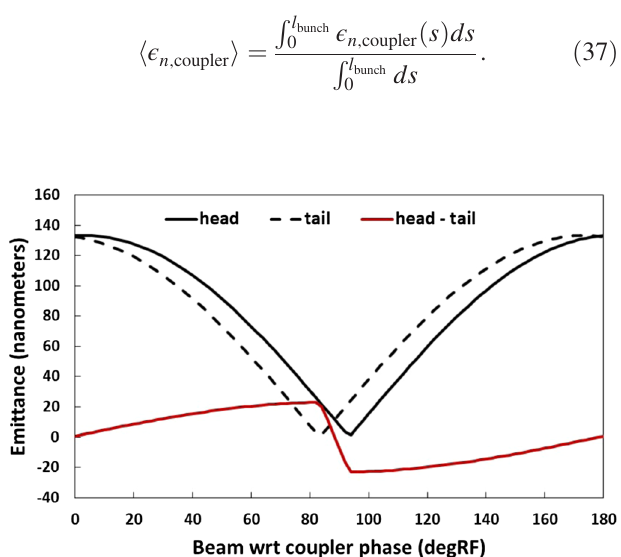
10 degrf, FIG. 9. The head ( s ¼ 0 , solid line) and tail ( ω s tail c ¼ dashed line) emittances vs phase for σ x ¼ 1 mm. The emittance difference in the head and tail (red line) is a maximum when the beam is on the crest of the rf waveform. The coupler voltage and 20 MV and v 3 . 4 þ 0 . 2 i Þ × 10 − 6 = mm, kick are V xy ¼ ð acc ¼ respectively, which are typical parameters for SRF cavities [20]. Here the unit degrf is a degree of phase at the rf frequency of 1.3